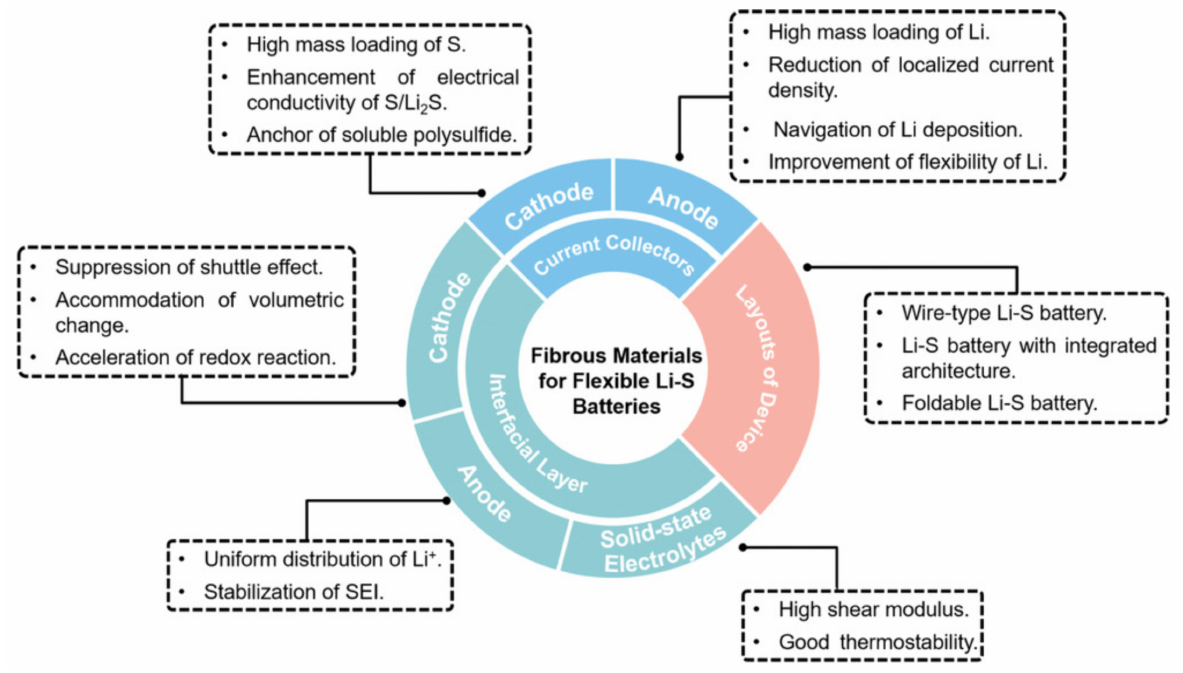
Figure 6. Advantages of fibrous framework in metal–sulfur batteries (adapted with permission from [157]. Adv. Ener. Mat., Wiley,